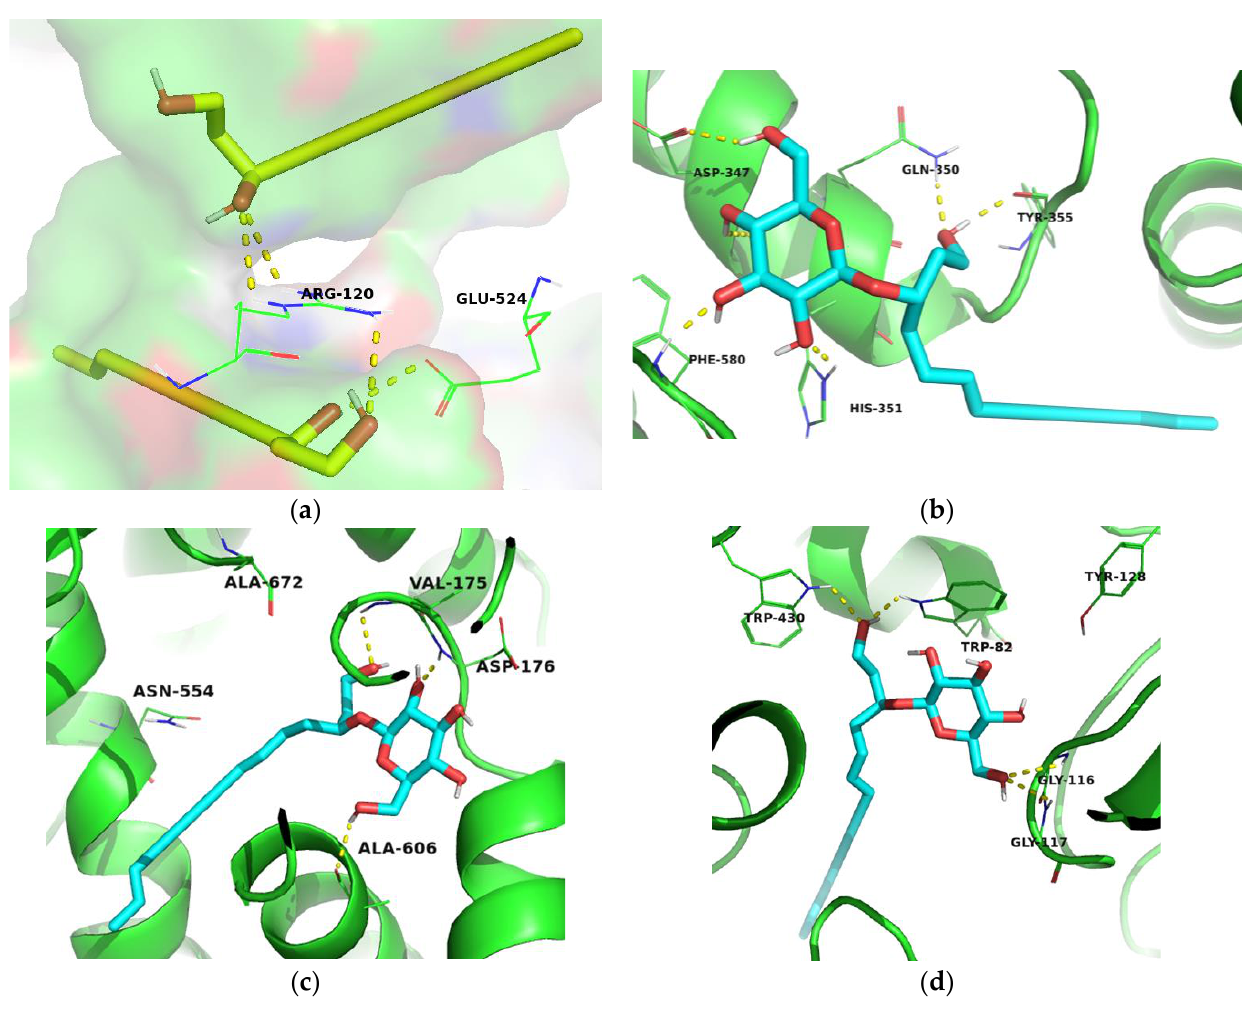
Figure 2. Three-dimensional molecular binding models of ( a ) Simultaneously docked molecules 1A and 1B (colored yellow) to the active site of COX-2; ( b ) docked molecule 4 (colored cyan) to the active site of COX-2; ( c ) docked molecule 4 (colored cyan) to the active site of 5-LOX; ( d ) docked molecule 4 (colored cyan) to the active site of BchE.